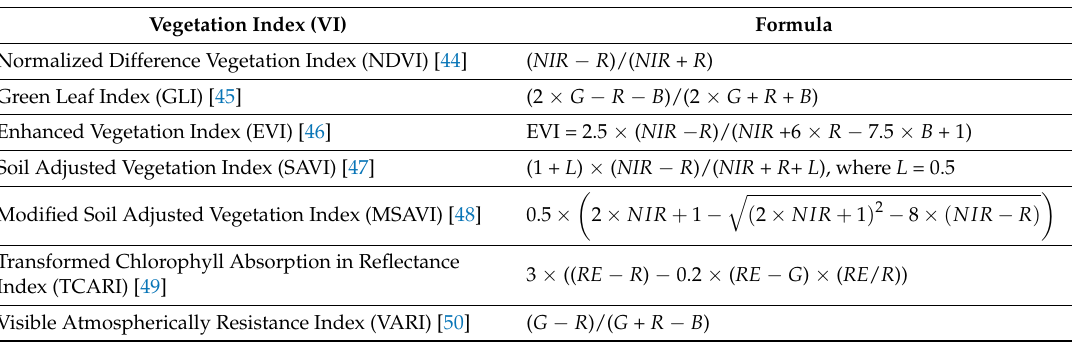
Table 1. Vegetation indices, formulas, and reference. WorldView-2 band names abbreviations are: R = Red, RE = Red edge, G = Green, B = Blue and NIR = Near IR-1. Vegetation Index (VI) Formula